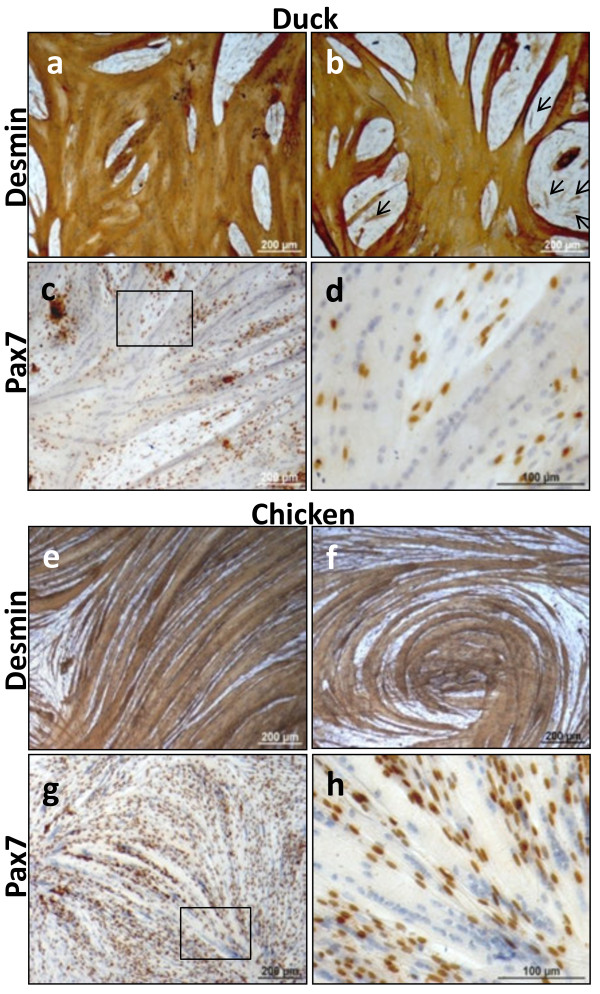
Terminally differentiated primary duck and chicken muscle cultures immunolabeled for the muscle markers desmin and Pax7, counterstained with Harris’ Haematoxylin. Duck breast muscle cells fused en masse to form large multi-nucleated syncytia. Extensive desmin presence (brown staining) in duck myotubes (a, b) with reduced detection of desmin confined to a small proportion of duck myoblasts (b, arrows). Duck myoblasts were identified by the expression of Pax7 in the myonuclei (brown staining) (c, d). Note the absence of Pax7 protein in myotubes. Chicken breast muscle cells achieved comparable level of fusion; myotubes in panel a and e each contained over 300 nuclei. Morphologically, fused chicken cells displayed more typically the myotubular structural shape (e, f). Chicken muscle cultures showed similar expression patterns of myogenic markers to duck cultures with desmin detection in the sarcoplasm of myotubes (e, f) and Pax7 protein in myoblast nuclei (g, h).